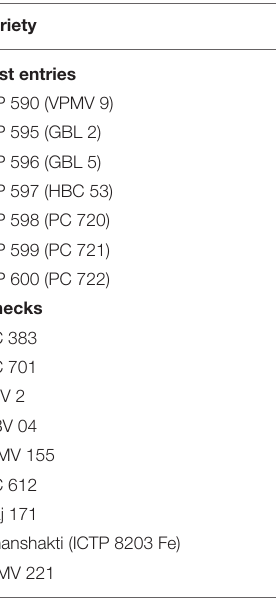
TABLE 1 | Varieties used in the